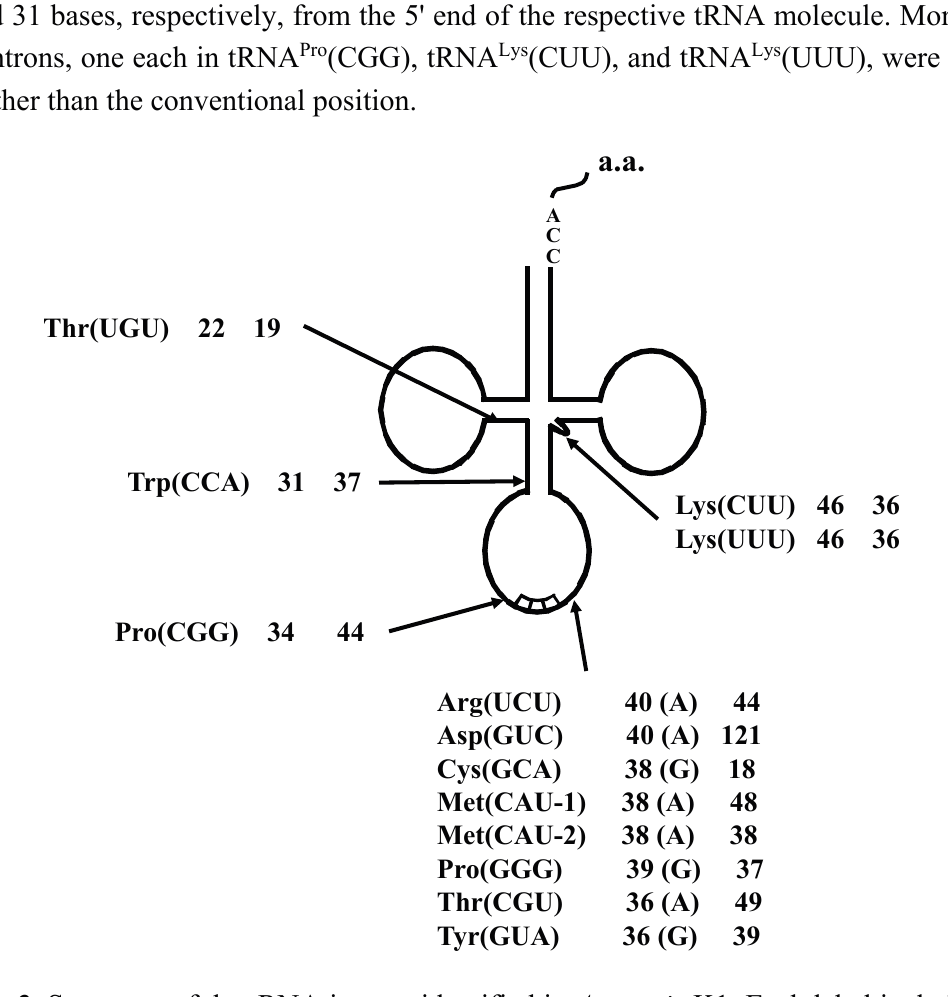
Figure 3. Summary of the tRNA introns identified in A. pernix K1. Each label includes the tRNA species, the respective intron positions from the 5' end of the respective tRNA, and the lengths of the introns. Characters within parentheses indicate the nucleotide one base 5' from the intron